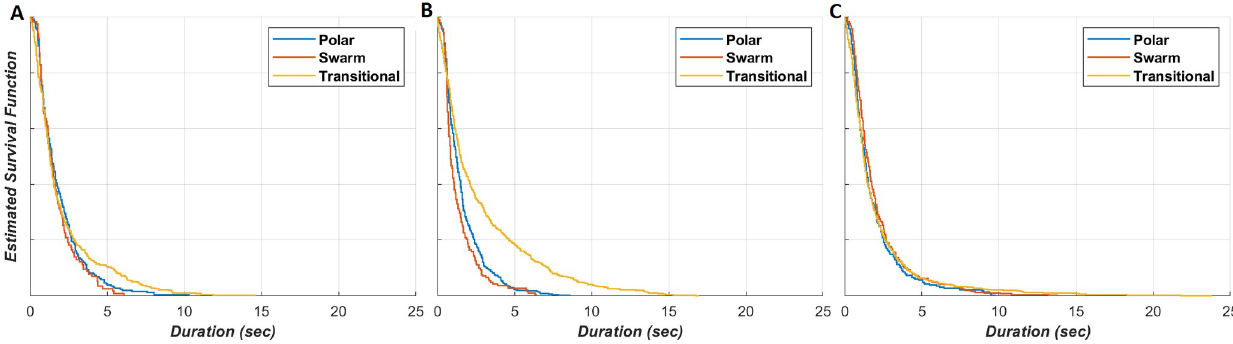
PLOS ONE | https://doi.org/10.1371/journal.pone.0251970 May 24,